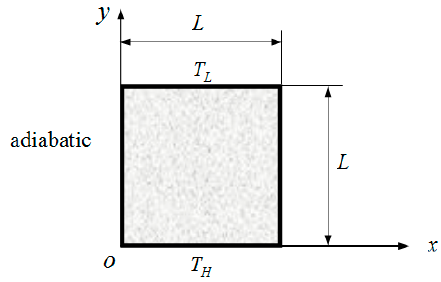
Figure 1. Cross-section of a primary particle chain.